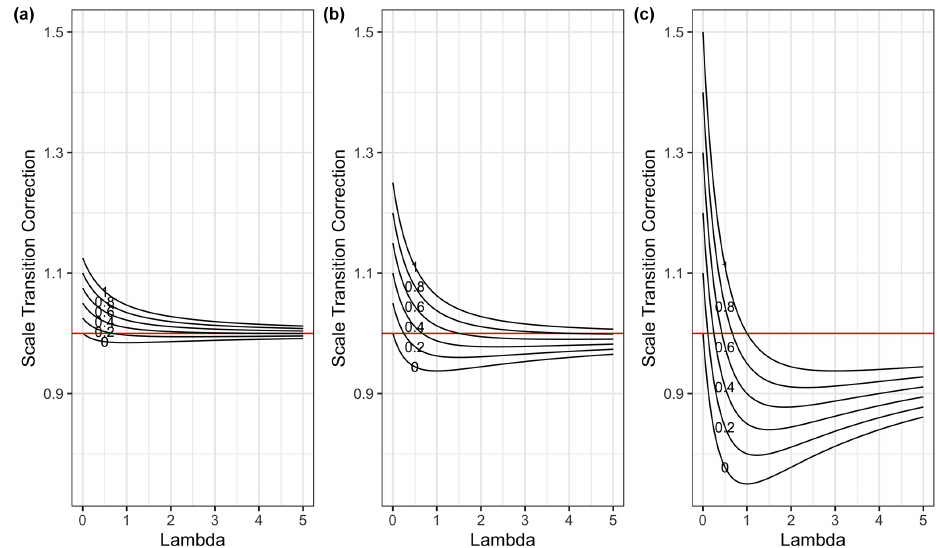
Figure 1. Scale transition correction for models given spatial colocation between microbes and substrate across a gradient of λ values and for a variety of correlation ρ values (0–1), with CV(SOC) held constant at 0.5, (a) CV(MB) = 0.25, (b) CV(MB) = 0.5 and (c) CV(MB = 1. Note that in panel (c) the system appears to converge on a value lower than 1. However, as λ increases, convergence to 1 does occur, albeit slowly, as it must according to Eq.